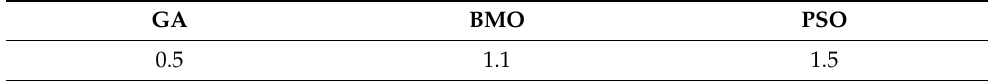
Table 5. Comparison of time-consuming of three methods (Unit: min).